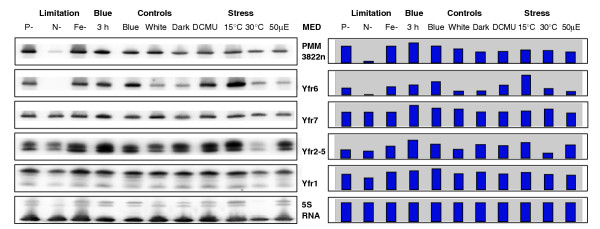
Test of transcript accumulation of Yfr1-7 from MED4 (MED) under different conditions. The left side shows the Northern hybridizations for which the following conditions were used: nutrient depletion (phosphate (P-), nitrogen (N-), iron (Fe-)); blue light for three hours (3 h); controls under blue (Blue), white (White) and no light (Dark); oxidative stress mediated by the application of 3-(3,4-dichlorophenyl)-1,1-N-N'-dimethylurea (DCMU); low (15°C) and high (30°C) temperatures; and high light intensity (50 μE). For comparison, 5S rRNA was hybridized as an internal standard and the mRNA of gene PMM3822n which, with a length of approximately 250 nucleotides, was taken as an example for a small mRNA. Additional controls by quantitative RT-PCR for the genes isiB (Fe), glnA (N), pstS (P) and hli8 (high light) [data not shown] were carried out to confirm the effects of nutrient depletion or high light. The amounts of these mRNAs were enhanced by a factor of 79.7 (isiB), 5.8 (glnA), 2.8 (hli8) and 4.0 (pstS) under the respective treatment compared to standard conditions (data not shown). Yfr6 shows an inconstant signal; for example, at cold, blue/white light, N-, Yfr2 to Yfr5 were hybridized with the consensus oligonucleotide y_gen (Figure 5). The band intensities were quantified and normalized to the amount of 5S rRNA as an internal standard (right).